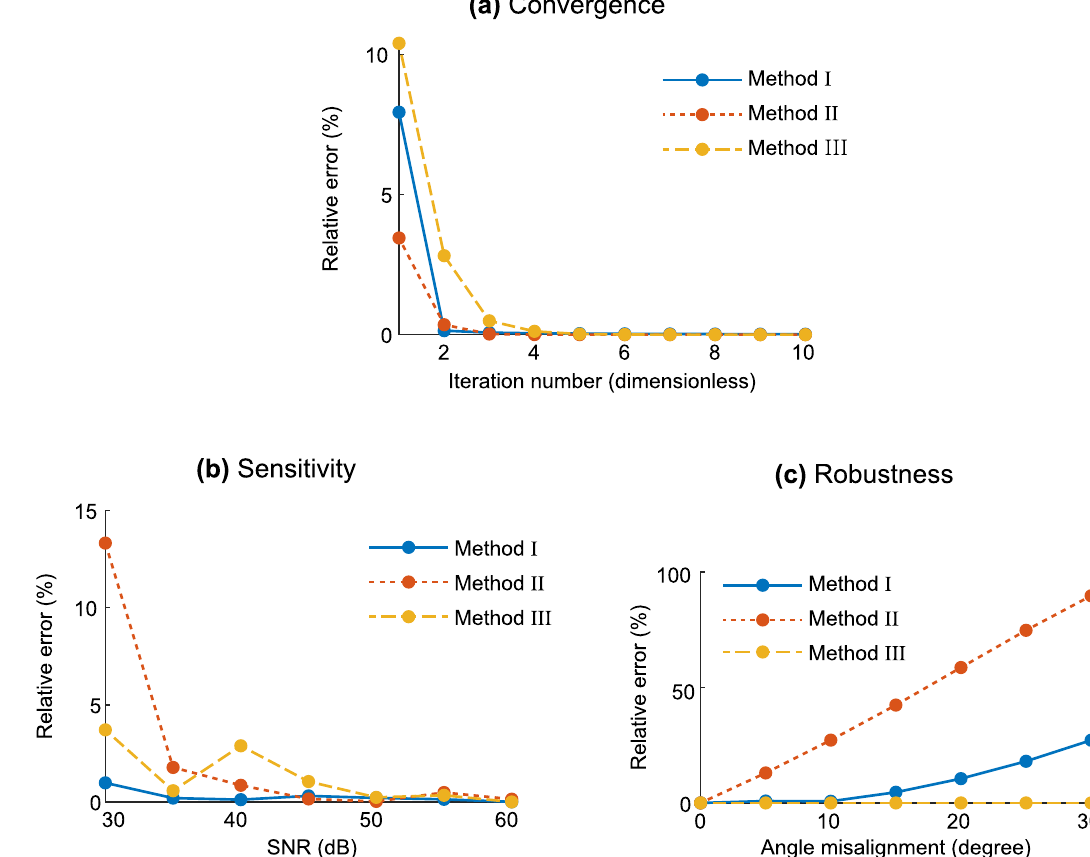
Figure 8. Performance comparison between methods considering the estimated anisotropy ratio α 2 . (a) Convergence of the with iteration number. (b) Sensitivity to measurement noise. (c) Robustness in front of needle angle